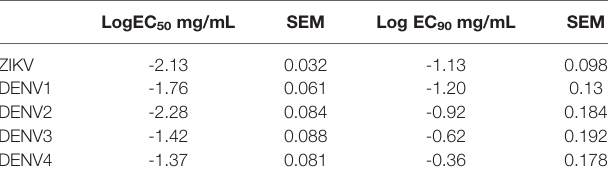
TABLE 1 | Analysis of neutralization effective concentration of ZIKV-IG against ZIKV and the four serotypes of